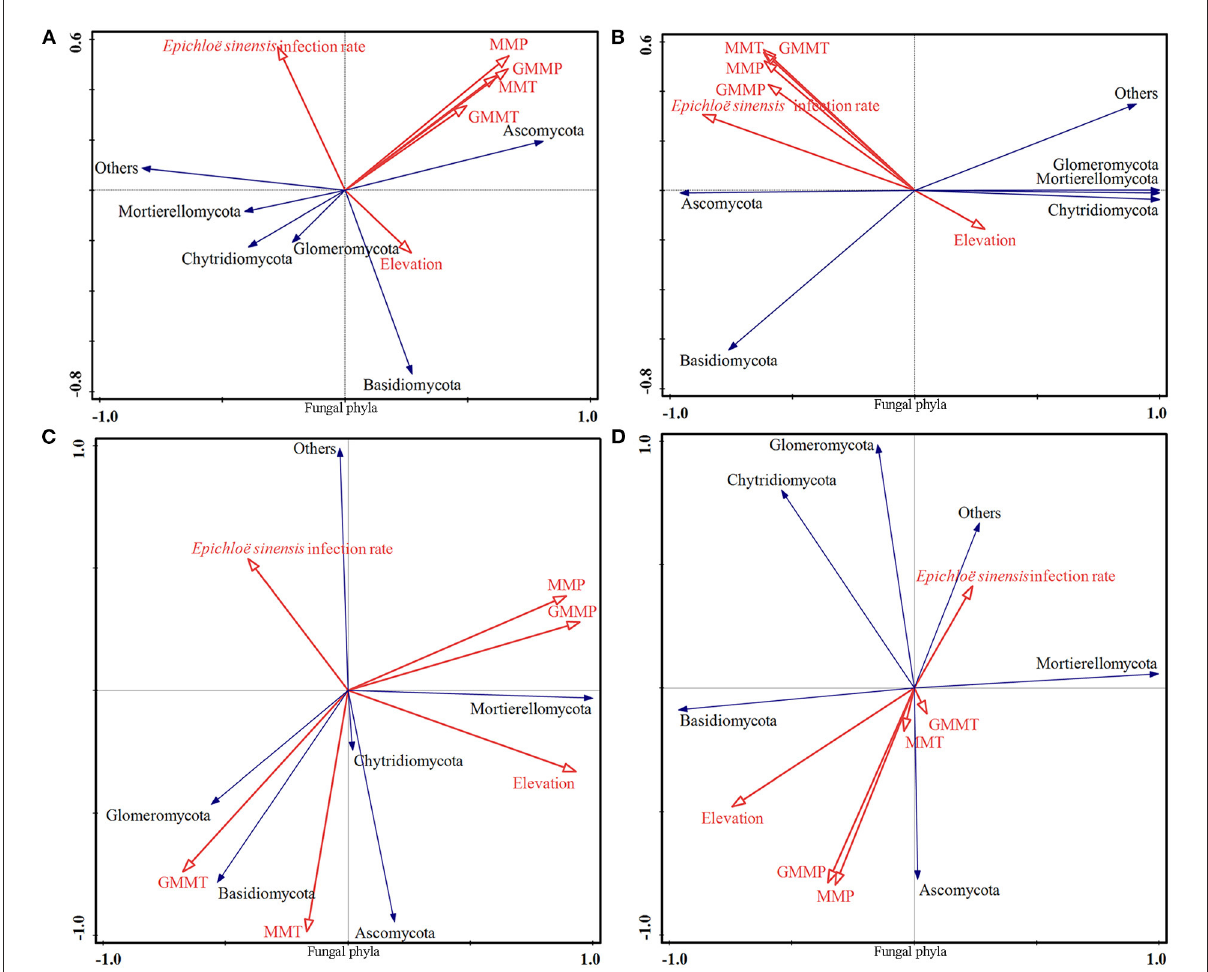
FIGURE6 Effect of environmental factors on fungal phyla. (A) on overall elevation (2,589–5,197m). (B) on high elevation (2,589–3,000m); (C) on medium-high elevation (3,000–4,500m); (D) and on extremely high elevation (4,500–5,197m). The microbial parameters (expressed as response variables in the RDA) were presented as black line vectors, and the environmental factors (explanatory variables) were presented as red line vectors. MMT, monthly mean temperature; MMP, monthly mean precipitation; GMMT, growing monthly mean temperature; GMMP, growing monthly mean